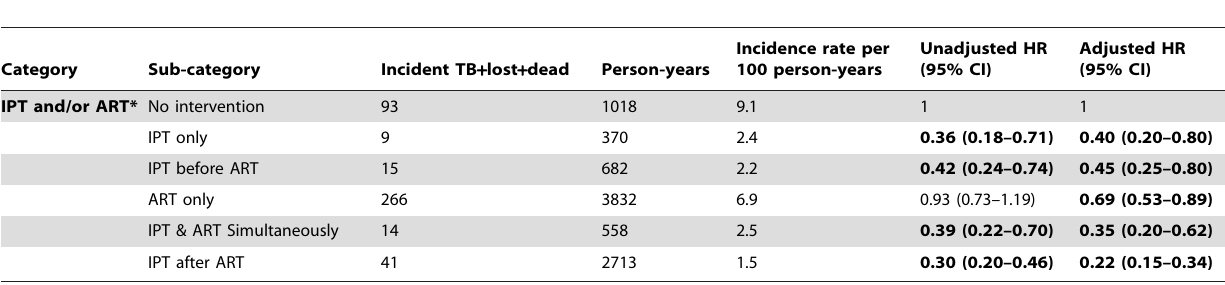
Table 4. Sensitivity analysis for effectiveness of IPT with or without ART using Cox proportional hazards model among patients on ART assuming those who were lost to follow-up and dead developed TB in SNNP region, Ethiopia, September 2007 to August